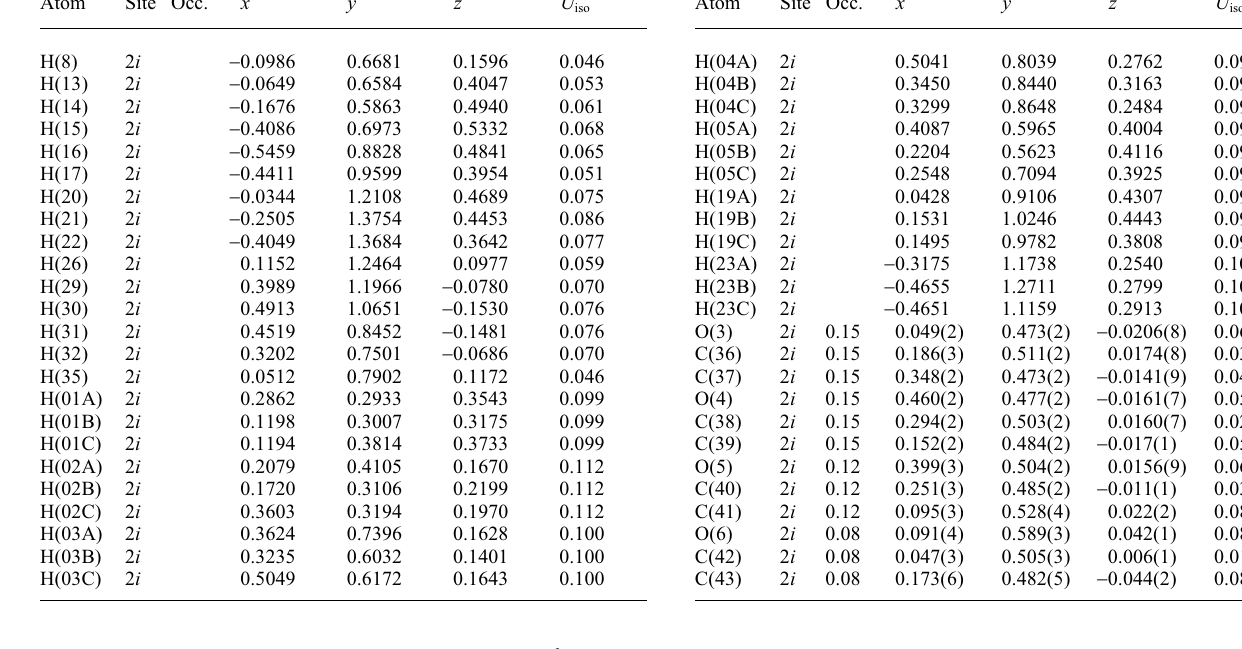
Table 3. Atomic coordinates and displacement parameters (in Å 2